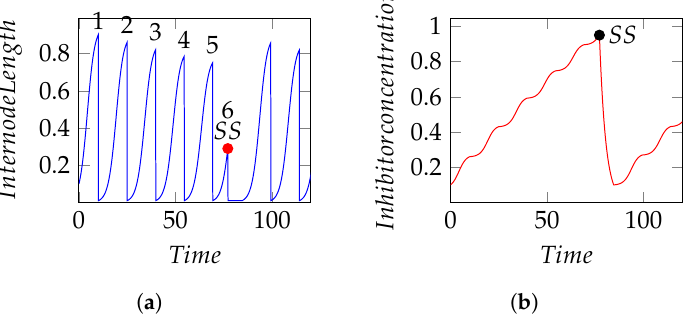
Figure 6. Internode length and Inhibitor concentration simulations in Simile as expected behaviour with fixed environmental parameters. SS = Season Stop. Numbers are the count of internodes. ( a ) Internode Length; ( b ) Inhibitor